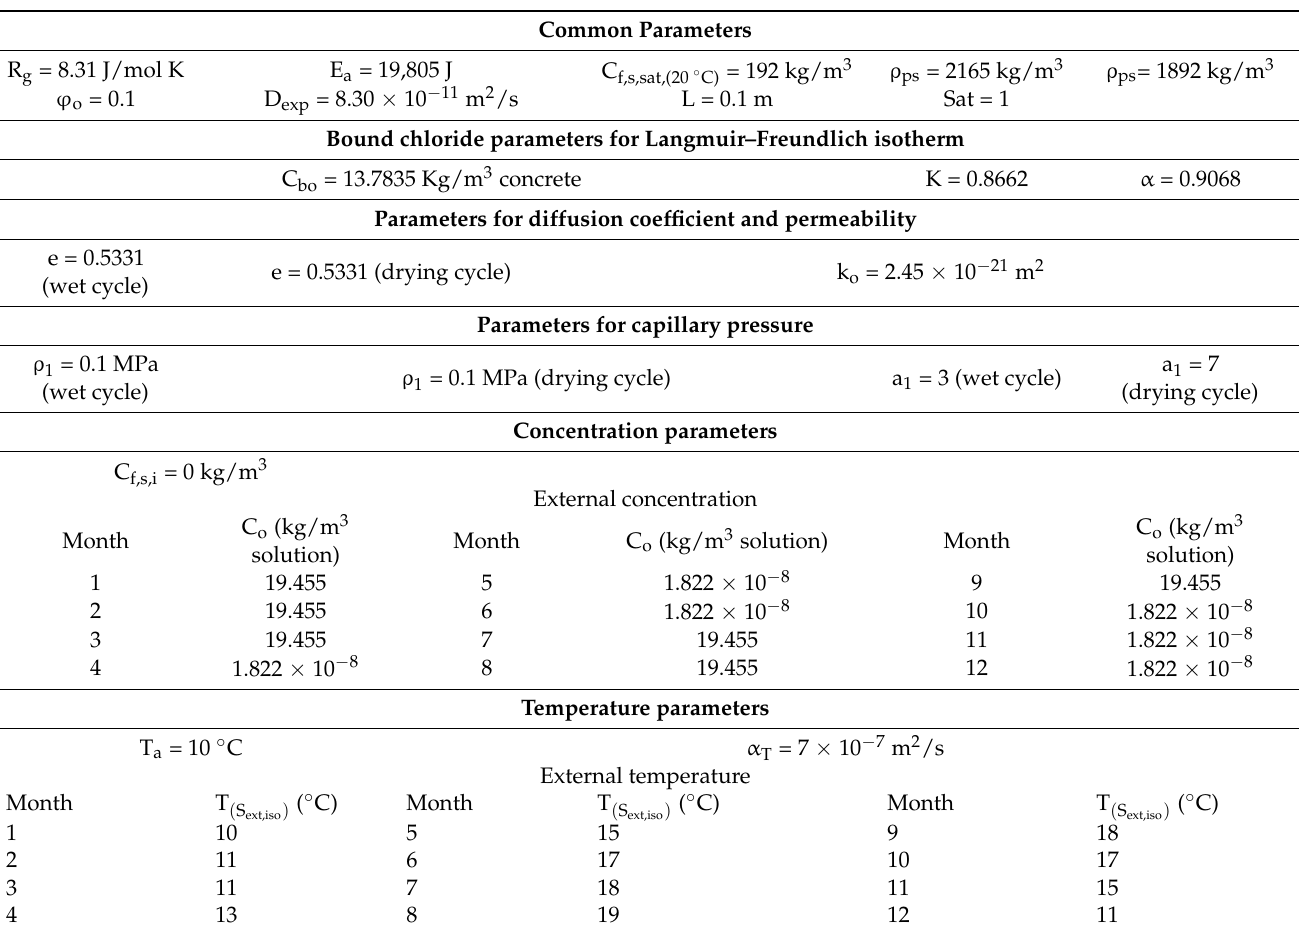
Table 6. Unsaturated problem. Data of the third application.